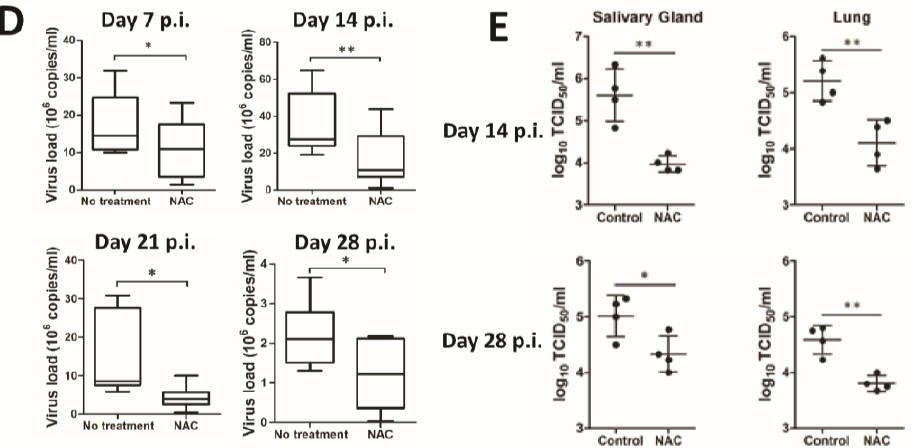
Figure 5. The H 2 O 2 scavenger NAC inhibits MCMV lytic replication in vivo . ROS production upon primary infection of MEF cells with MCMV. Confluent MEF cells in 24-well plates were serum starved for 2 h, incubated with DMEM containing 10 μM H 2 -DCFDA for 30 min at 37 °C, and infected with either UV-inactivated MCMV or MCMV (MOI = 0.5). H 2 -DCFDA fluorescence were stained between infected and uninfected cells at indicated times ( A ). Fold induction of ROS production in infected cells relative to UV-HCMV (UV) infected cells ( B ). The culture supernatant collected at 72 h post infection with MCMV at an MOI of 0.5 detected the viral DNA ( C ). Mice were treated intragastrically with 400 μL of 40 mM NAC in water every day, from three days before intraperitoneal inoculation with MCMV (Smith strain, 5 × 10 3 p.f.u). One hundred microliters of whole blood from each mouse were examined. Viral loads in blood samples of control ( n = 14) and NAC-treated ( n = 14) mice at indicated days post infection ( D ). Related infectious viral titer in the salivary glands and in the lung was detected at 14 and 28 days post infection by TCID 50 assay ( E ). * p < 0.05 or ** p < 0.01 for treated versus untreated cells and mice.